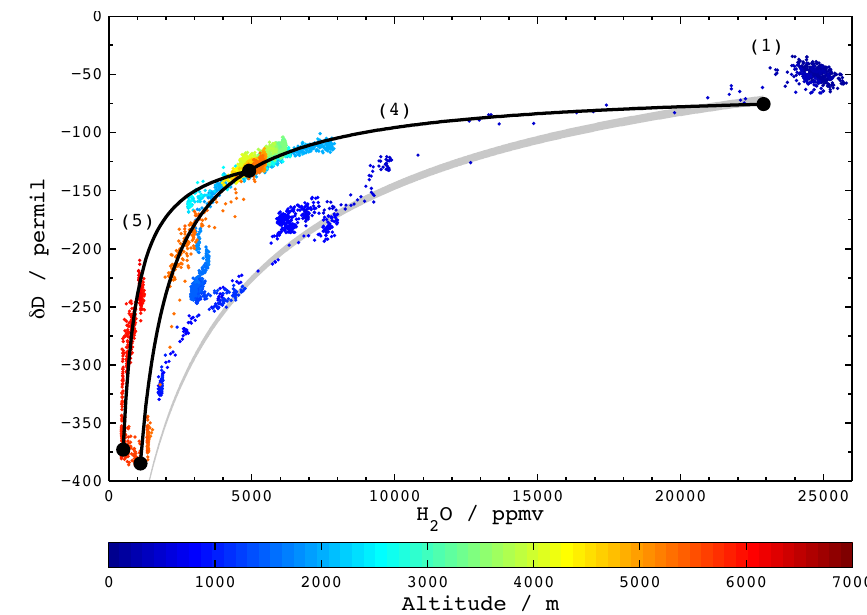
Figure 11. Distribution of H 2 O and δ D measurements (1Hz) during the descending branch of the flight on 31 July 2013. The color code represents the sampling altitude. The grey shaded area depicts a range of possible Rayleigh models assuming SST = 22 . 5 ◦ C and RH = 80% for ocean water with δ D = 0‰ (VSMOW, lower boundary) and δ D = + 7‰ (upper boundary). The solid lines represent air mass mixing of (4) MBL and UT air and (5) air at intermediate altitude and UT air (numbers according to levels in Fig.